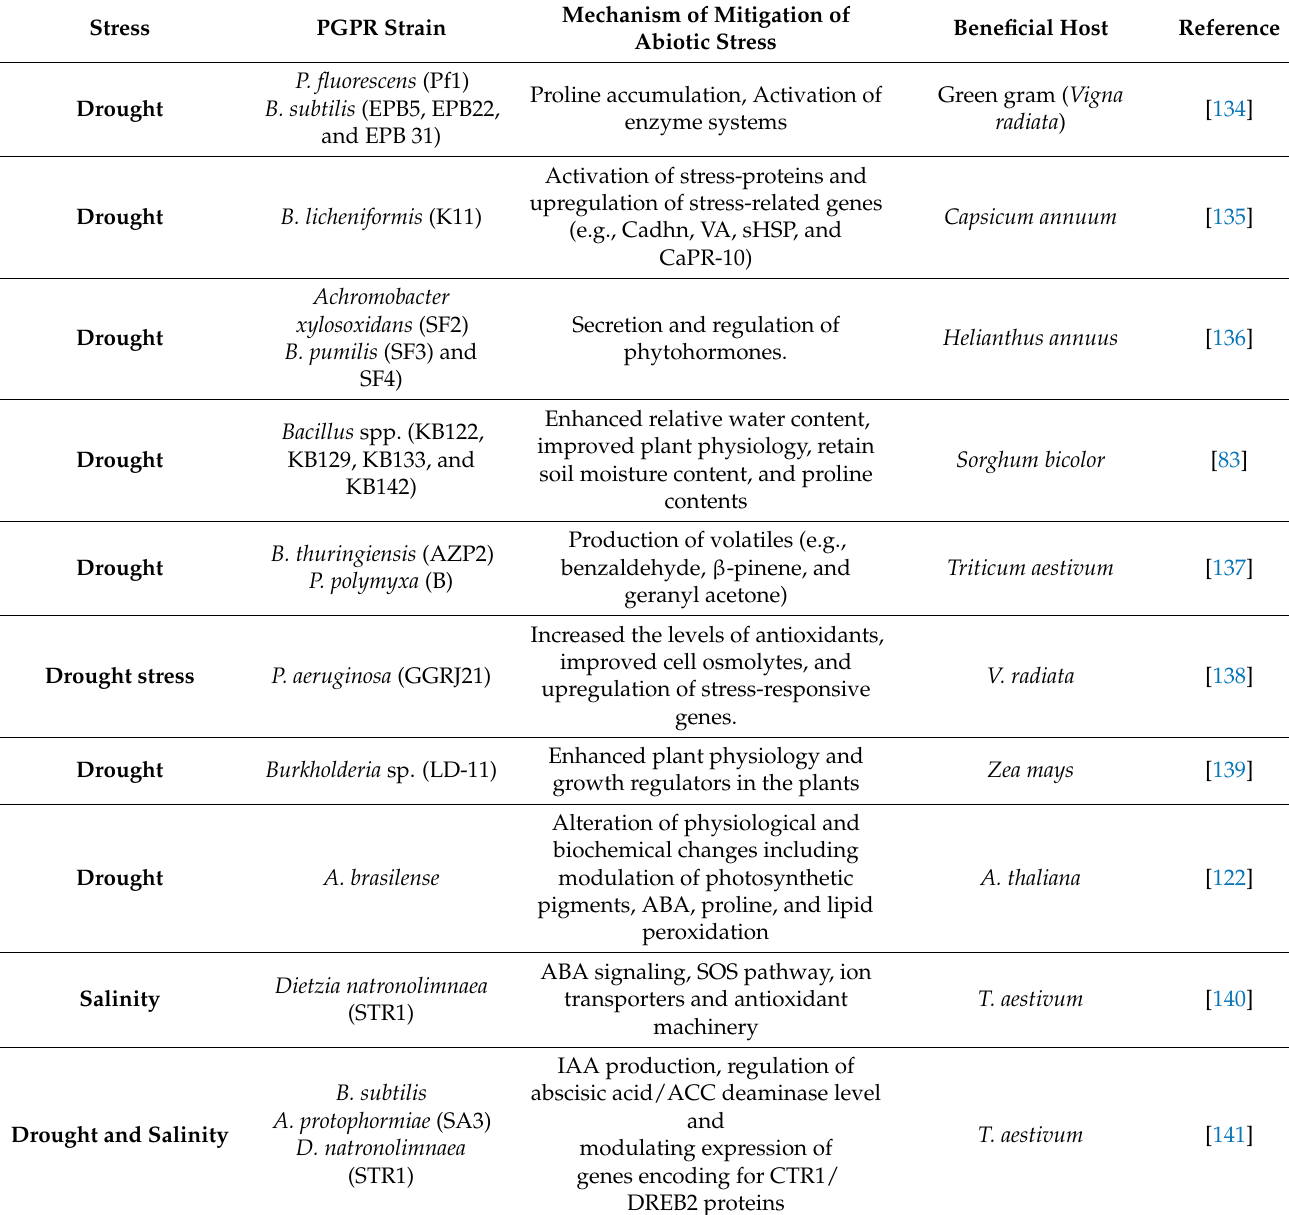
Table 2. Alleviation of abiotic stresses mediated by potential beneficial